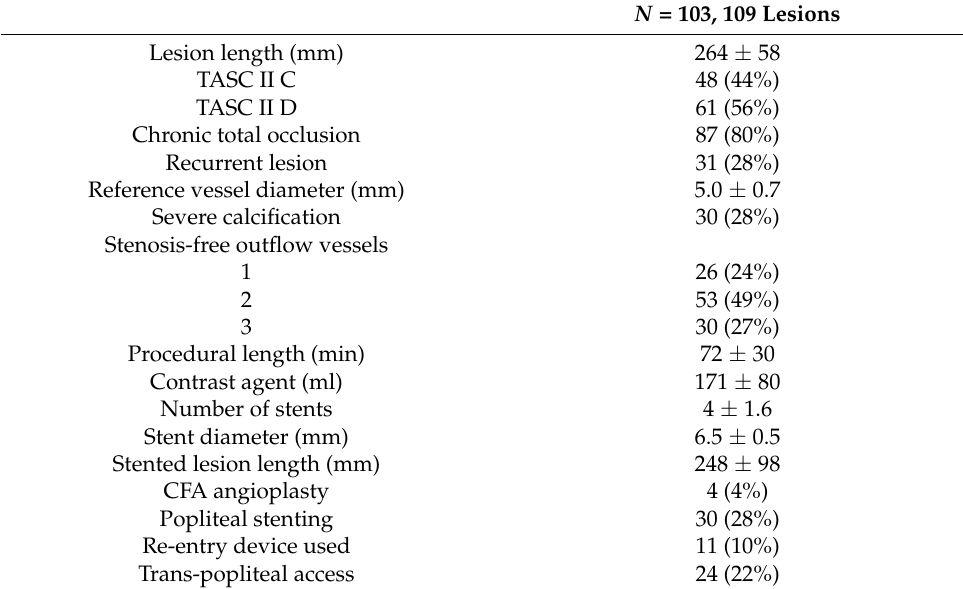
Table 2. Lesion and procedural